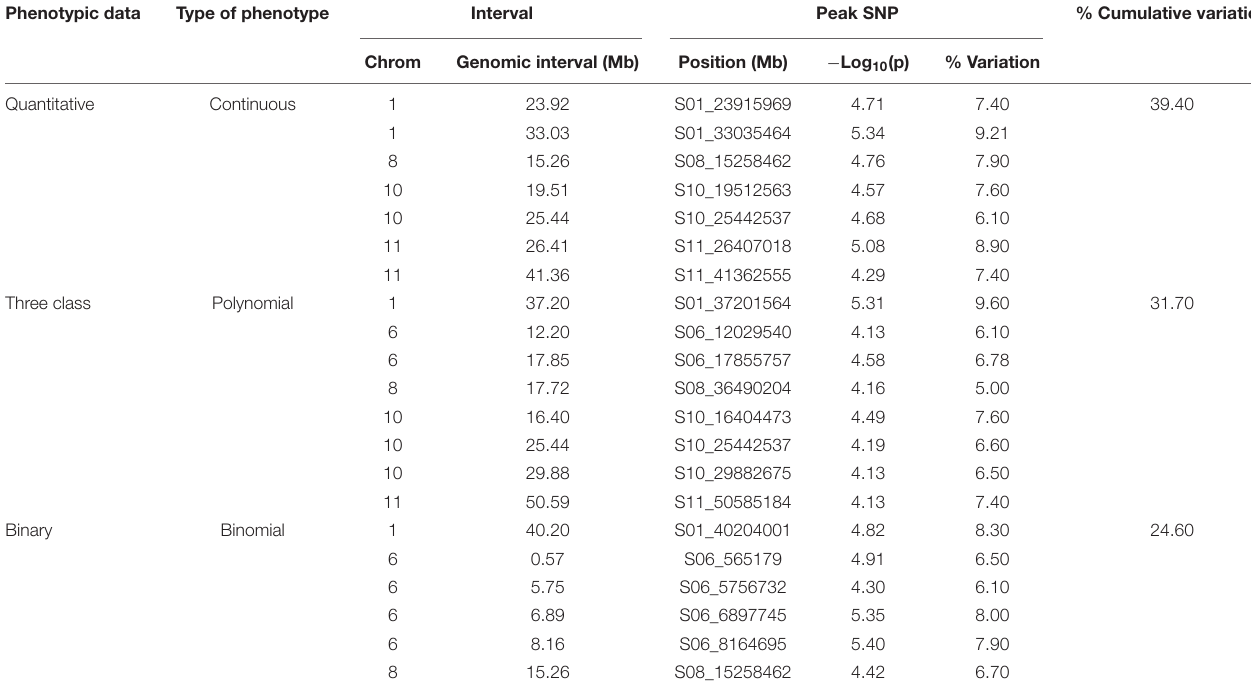
TABLE 5 | GEMMA GWAS results of MDP genotypes for the three phenotypic scoring